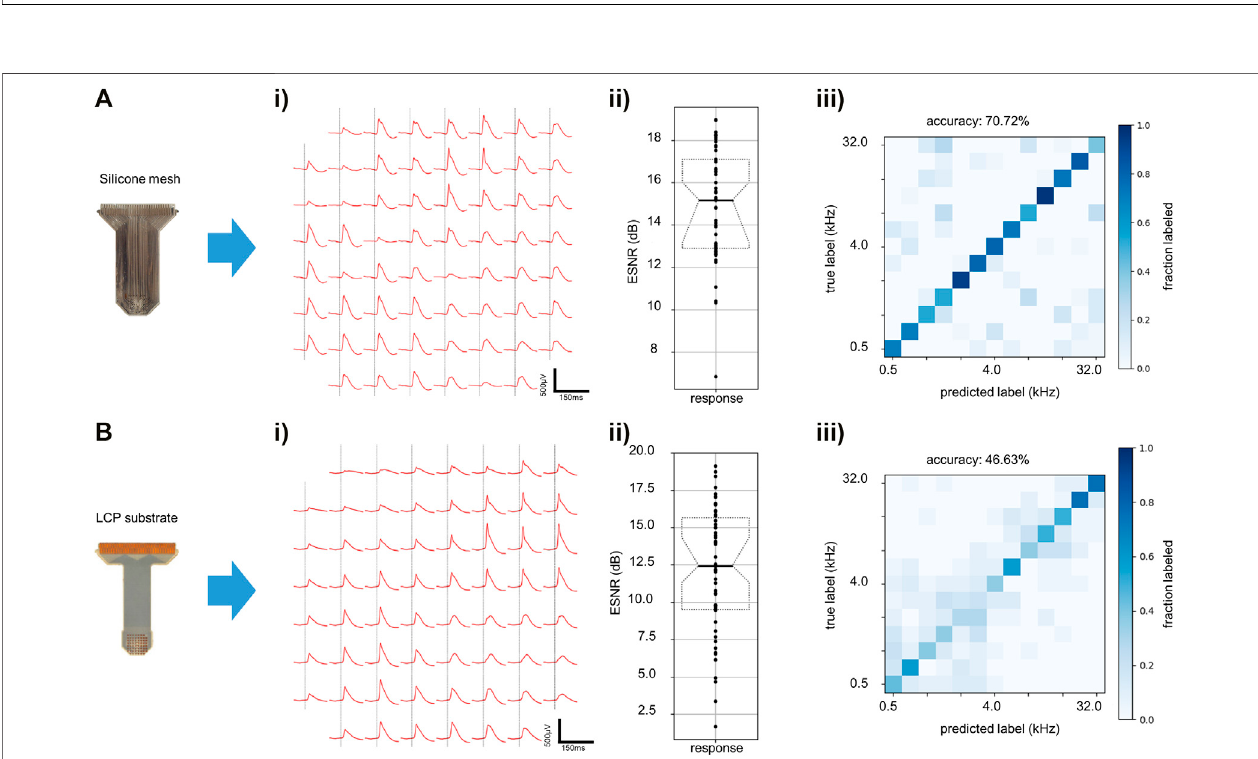
FIGURE 5 | Electrode recording capability testing. (A) Silicone electrode in vivo results. (i) Evoked responses to auditory clicks using reinforced silicone electrode array recorded using aconventional recordingsystem (Intan). (ii) ESNR for “ click ” stimulus on all contacts on reinforced silicone electrodearray. (iii) Prediction accuracy of recordings using reinforced silicone electrode array with 13 auditory stimulus tones (chance = 8%). (B) LCP electrode array in vivo results. (i) Evoked responses to clicks for LCP electrode array recorded on Intan. (ii) ESNR for “ click ” stimulus on all contacts on LCP electrode array. (iii) Prediction accuracy of recordings using LCP electrode array for 13 stimulus tones (chance =